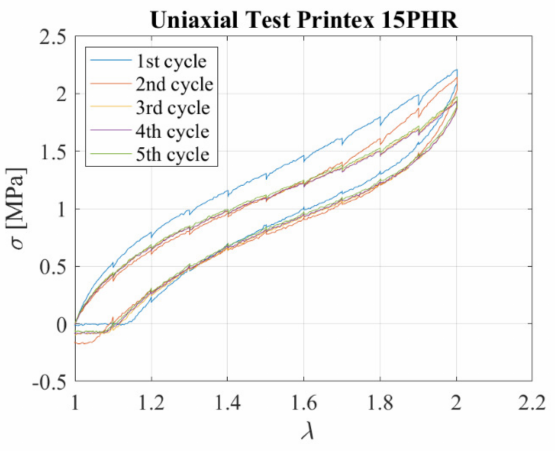
Figure 12. Tensile stress-extension curves for 5 cycles: Nominal stress vs